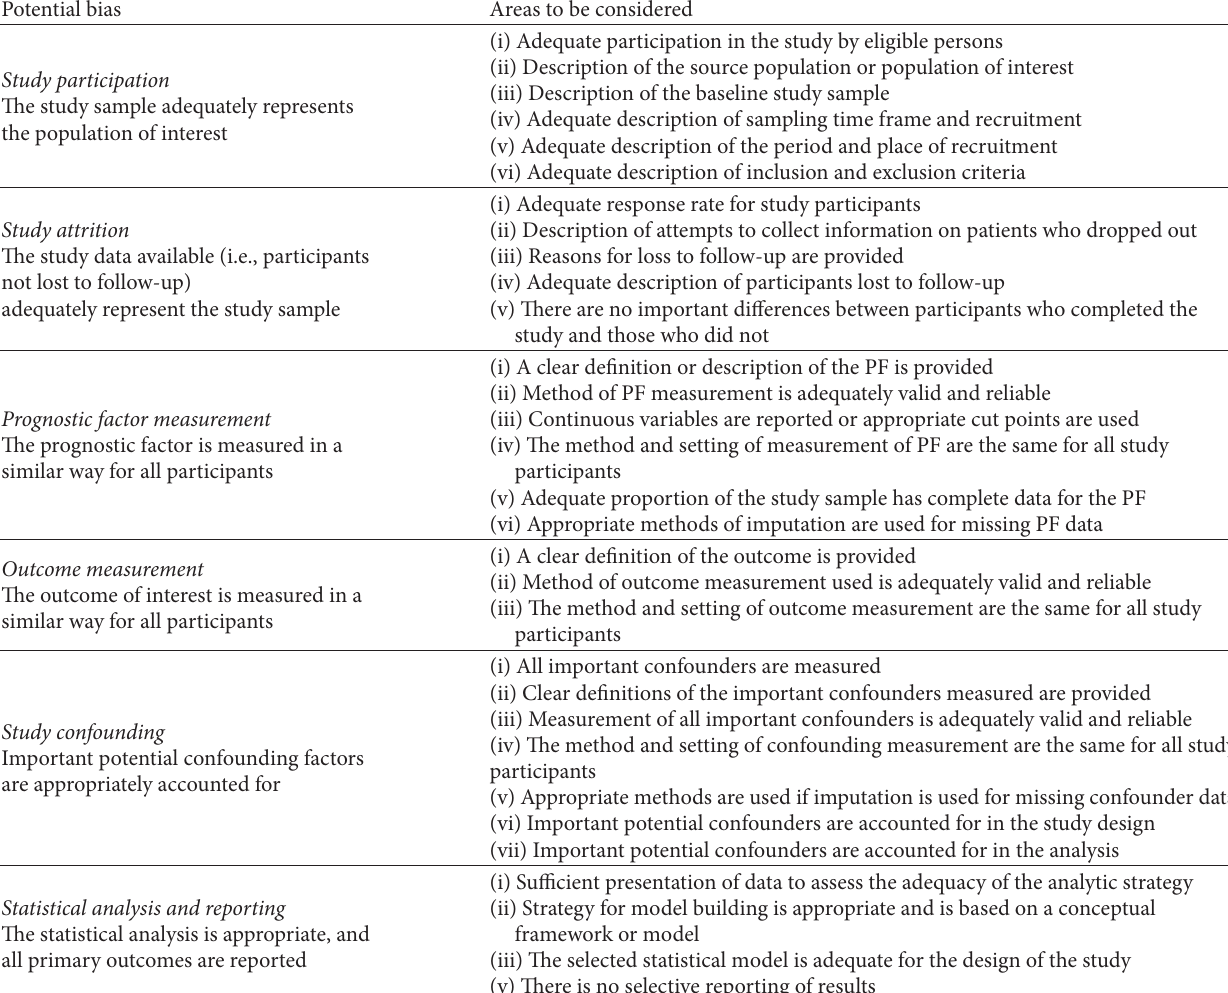
Table 1: Criteria for determining risk of bias (adapted from the QUIPS tool ∗